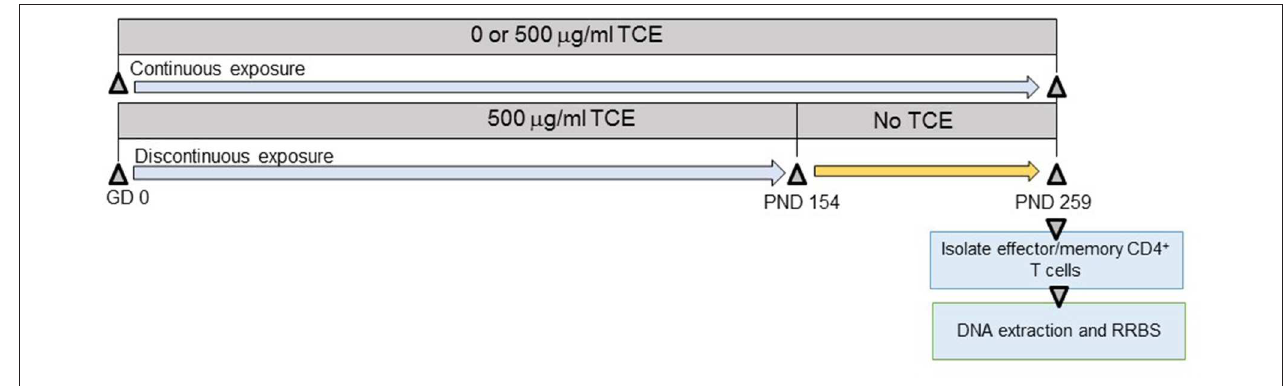
FIGURE 1 | Experimental design. Prior to breeding, female MRL + / + mice were randomly assigned to treatment groups consisting of (1) vehicle control; (2) 500 µ g/ml TCE. Female offspring were exposed continuously during development during gestation, lactation, and directly via the drinking water during early life. At PND 154 TCE was removed from the drinking water from a subset of the offspring. The remaining mice continued vehicle or TCE in the drinking water until PND 259 when all animals were euthanized. CD4 + T cells were purified into effector/memory subsets and subjected to DNA extraction and RRBS analysis as described in the